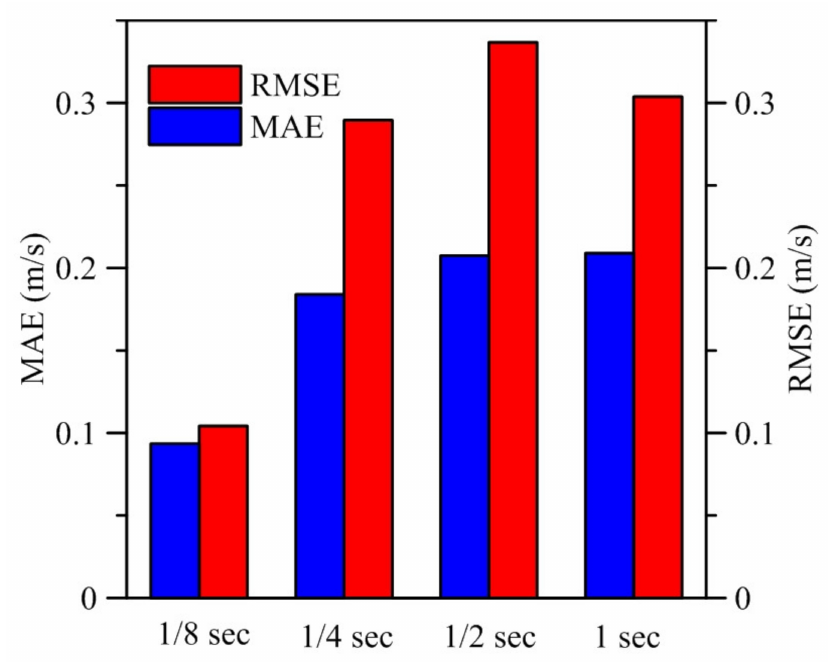
Figure 12. The statistical errors of surface velocity for different image acquisition time